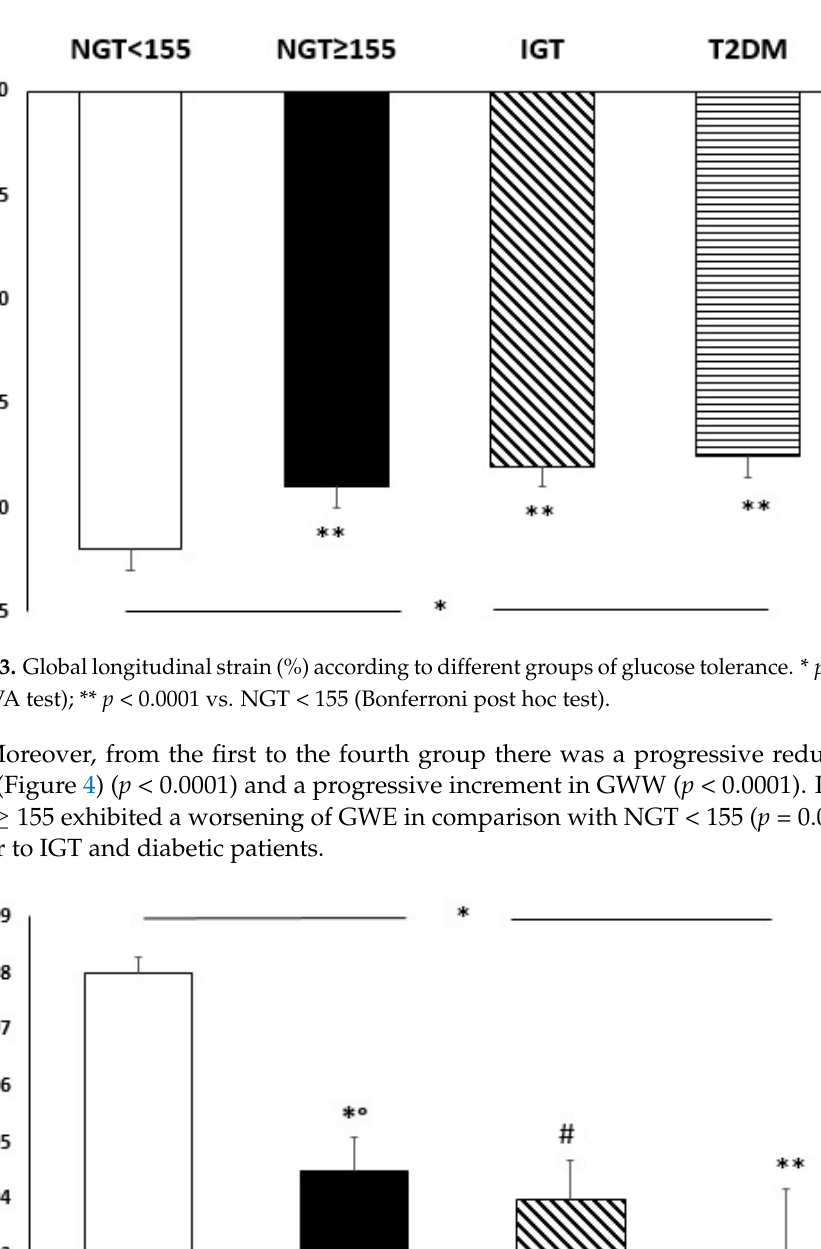
from the NGT < 155 group to T2DM group. No differences were highlighted in GLS epi values among the four groups.